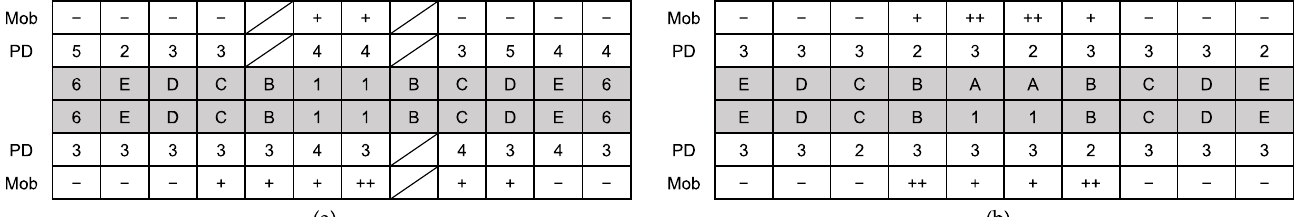
Figure 2. Panoramic radiography: ( a ) Older sister (seven years and three months); ( b ) Younger sister (six years and one month).